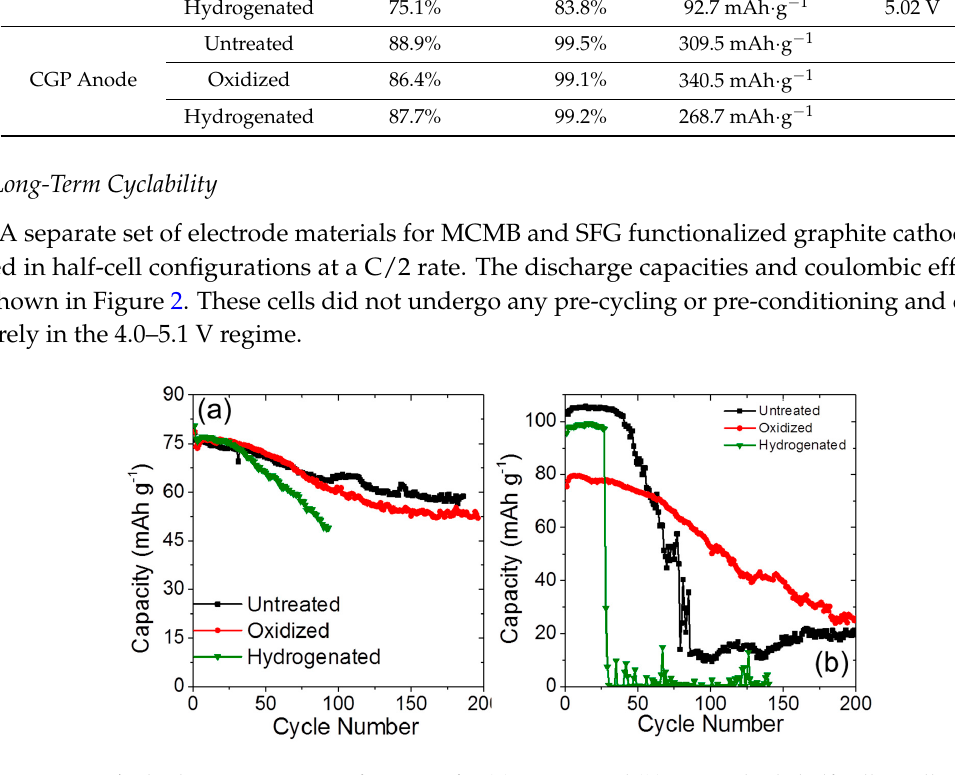
Figure 2 . C/2 discharge capacity performance for ( a ) MCMB and ( b ) SFG cathode half-cells. Cells were tested until discernible failure or 200 cycles.